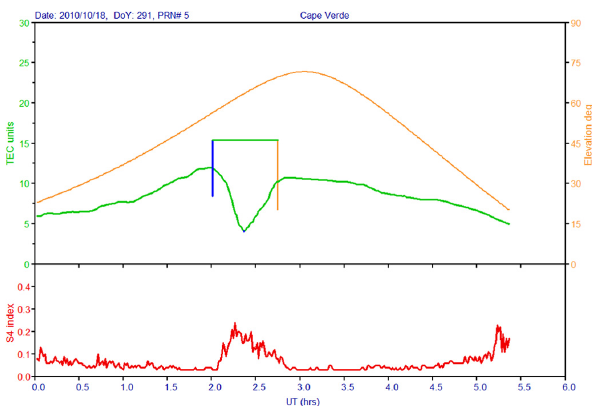
Fig. 2. Example of the measurements at Cape Verde (18 Octo- ber 2010). The top plot shows the TEC measurements and also the elevation angle of the satellite. Bottom plot shows S4 index mea- surements at same location. In this example the depletion depth is about